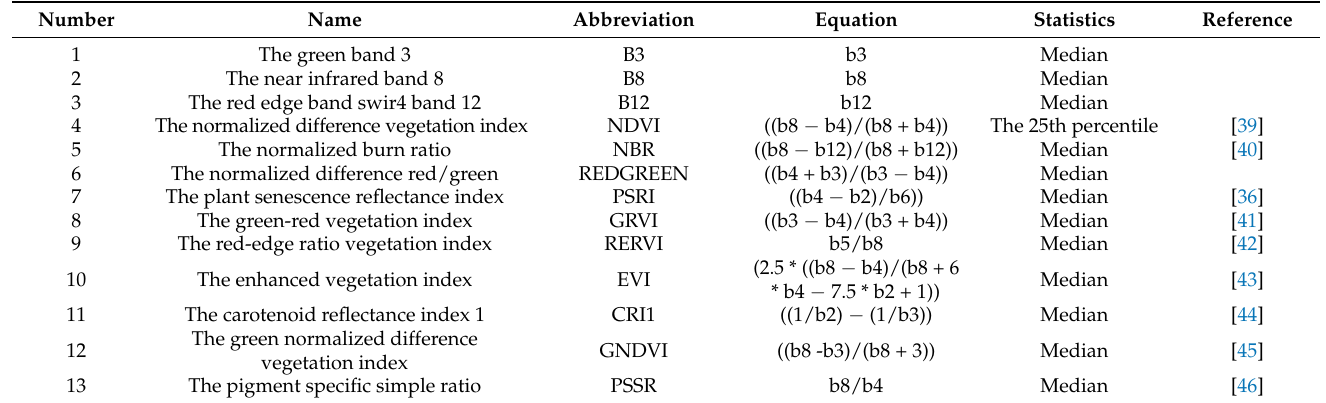
Table 1. List of input variables from Sentinel-2 in the deep learning model showing the names, abbreviations, equations, and references for equations. See footnotes for the various Sentinel-2 bands that were